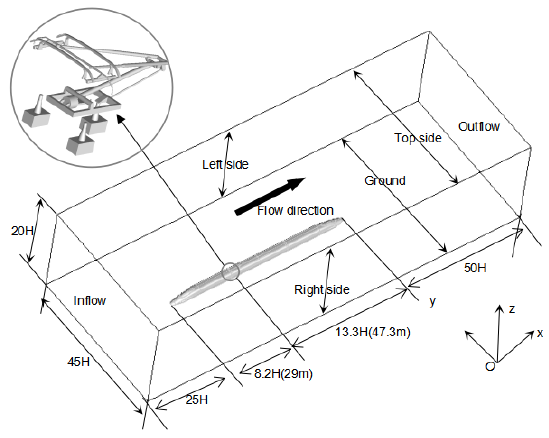
Figure 3. Computational domain for flow field and aerodynamic noise.